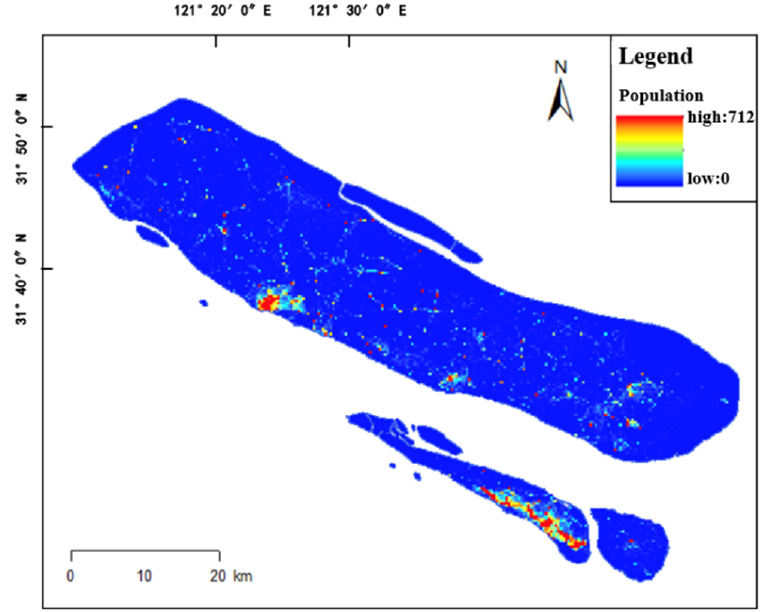
Figure 3. Population distribution in Chongming District in a raster format at 12:00 p.m. on